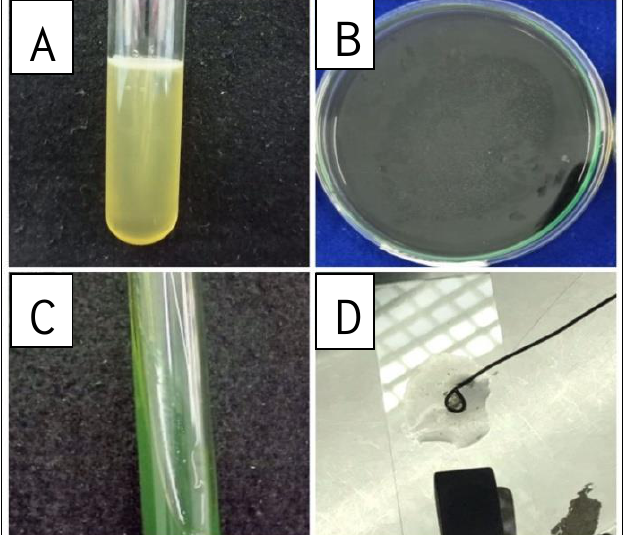
Figure 1: Results of biochemical characterization tests for Bacillus subtilis UTMP11, Bacillus subtilis UTMP12, Bacillus tequilensis UTMP14, Bacillus subtilis UTMP15 and Bacillus tequilensis UTMSA14 consisting of (a) motility, (b) starch hydrolysis, (c) citrate, and (d) catalase tests. Source: Authors, (2021).